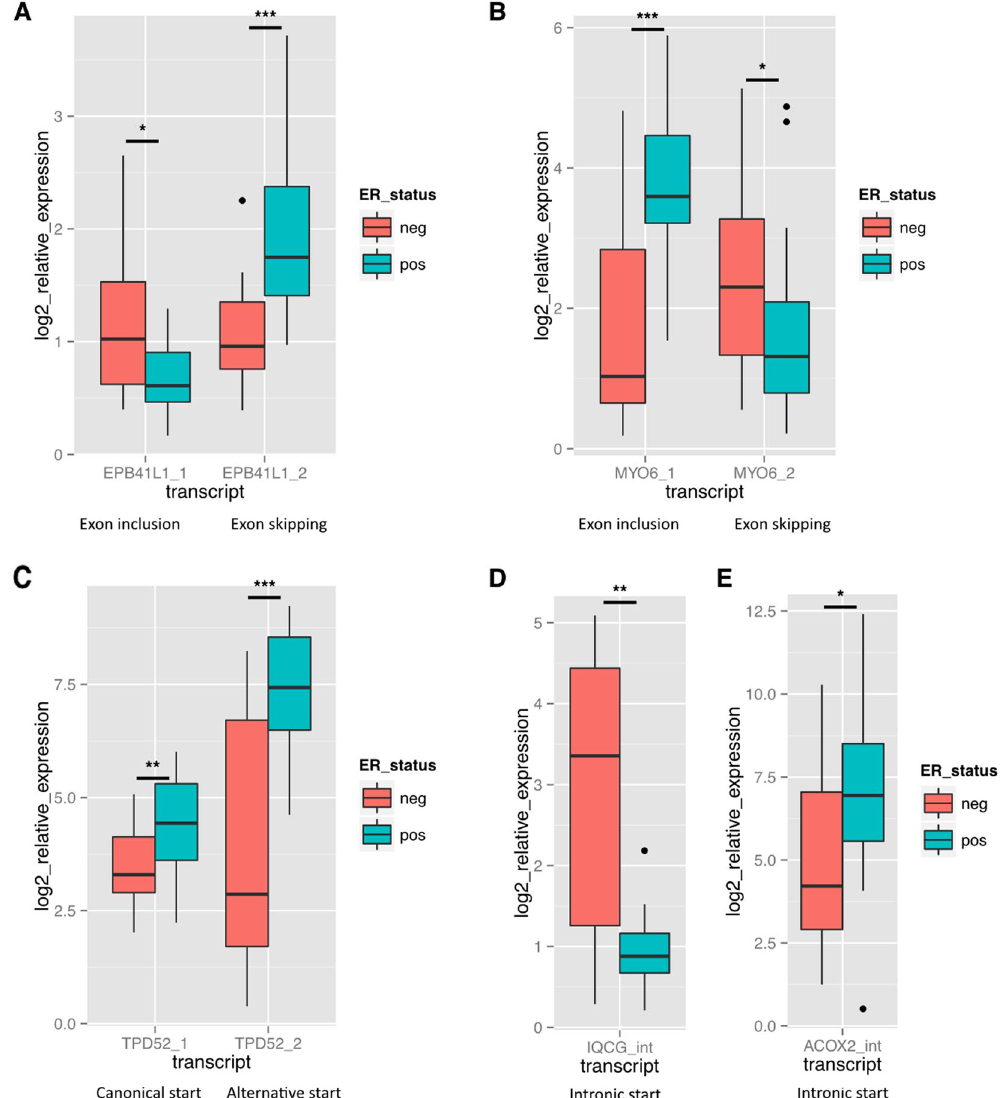
Figure 5. Validation of splicing and transcriptional events by Taqman qRT-PCR in an independent patient cohort. PCR primers and Taqman probes were designed to specifically detect transcriptional events in 5 genes in an independent cohort consisting of 20 ER + HER2 − and 20 ER − HER2 − patients from the MicMa cohort. Log2 expression is shown relative to normal breast RNA. PMM1 and RPL32 were used for normalization. The following events were measured: ( A) The inclusion and skipping of exon chr20:34797410-34797820 in EPB41L1 . ( B ) The inclusion and skipping of exon chr6:76608090-76608128 in MYO6 . ( C ) An alternative start exon (chr8:80992550-80993010) and the “canonical” start exon (chr8:81083660-81083836) of TPD52 . ( D ) The intronic start transcript of IQCG . ( E ) The intronic start transcript of ACOX2 . Association to ER status was assed using the Wilcoxon’s rank-sum test, *** p < 0.0005, ** p < 0.005, * p <